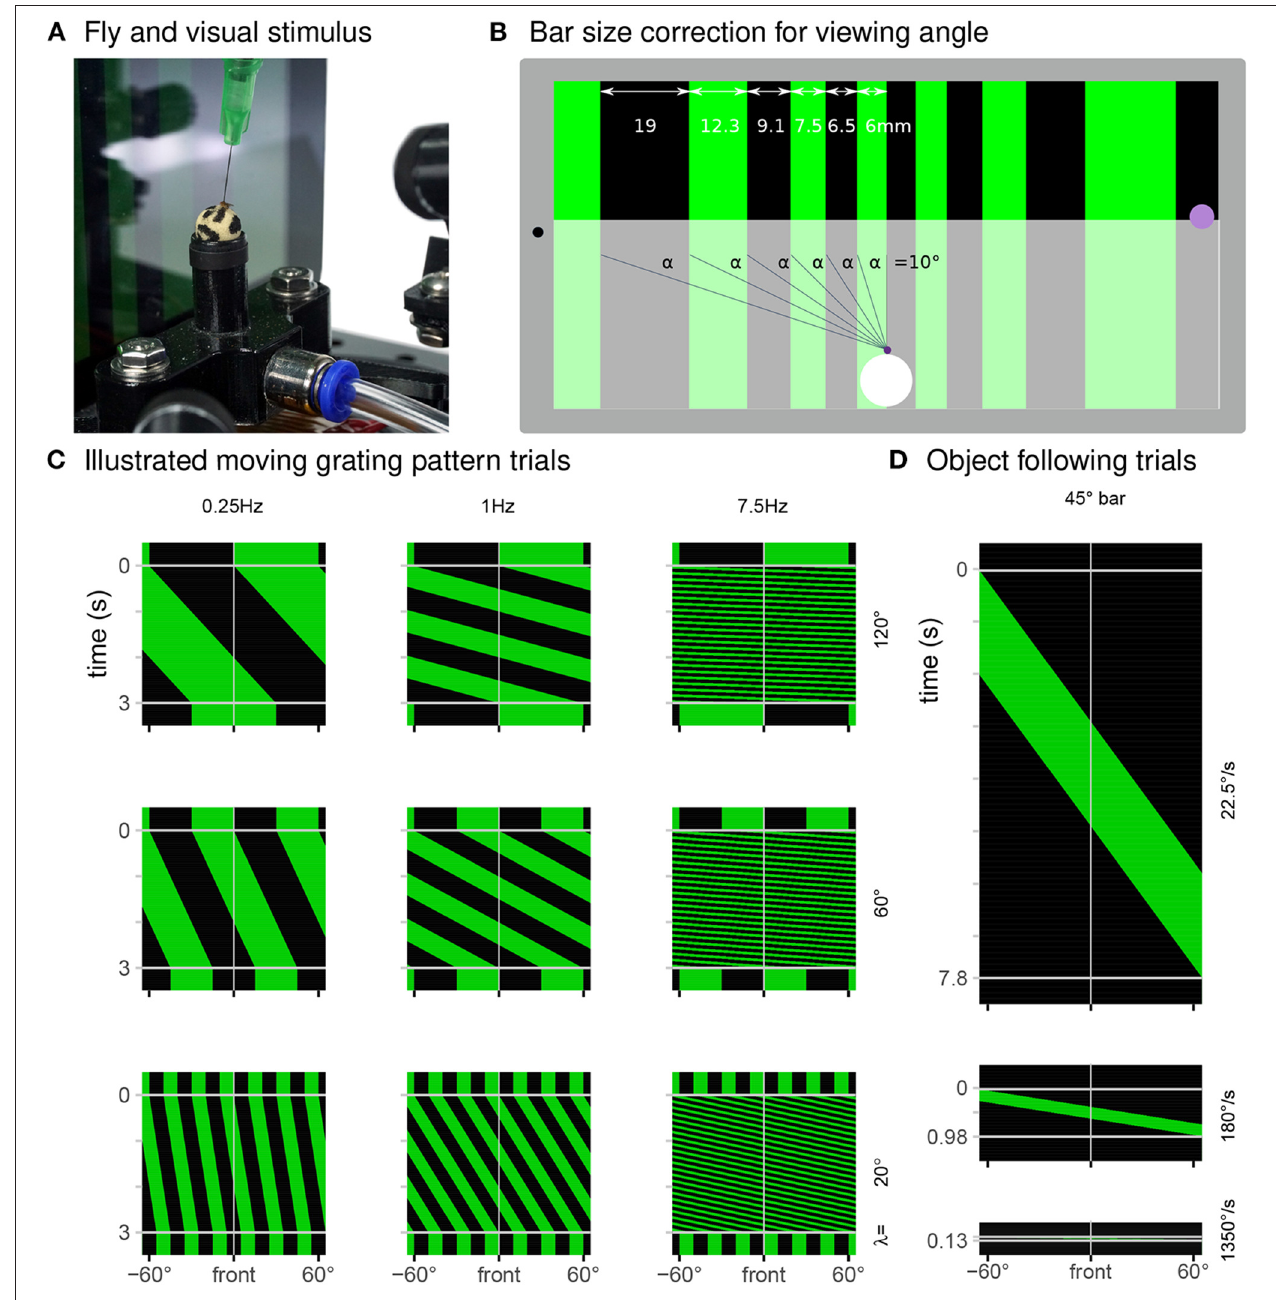
FIGURE 3 | Display used to present a range of visual stimuli. (A) In our typical experiment, a tethered fly walks on an air-supported foam sphere, while facing a tablet computer that displays a moving grating pattern. (B) The FlyFlix software renders a virtual scene that simulates a cylindrical display onto the tablet’s flat screen. The azimuthal span of each bar within a grating pattern is scaled to correct for the viewing angle—even though the dark bar on the left is ∼ 3 × as wide as the bright one in the center, they both span 10 ◦ from the perspective of the fly positioned 35mm in front of the display. The purple spot on the right marks the location where light measurements reported in Figures 4A–C were made. (C) Space-time representations of the display during trials showing a moving grating pattern (spatial axis displayed right-to-left, time axis is top-to-bottom). Each row of these images represents one horizontal slice through the displayed pattern, at the indicated point in time. For these 3 s trials showing moving patterns with different spatial periods and temporal frequencies, clock-wise motion appears as space-time tilts that go down and to the left. (D) Representation of displayed screen content during object following conditions for clockwise movement with the indicated speeds. views on the same experiment to different displays (a feature The FlyFlix client and server communicate over a not used in our standard setup). Once the client connects to the server, it shows a “Fullscreen” and a “Start” button, can deliver different experiments at specific URLs, or different